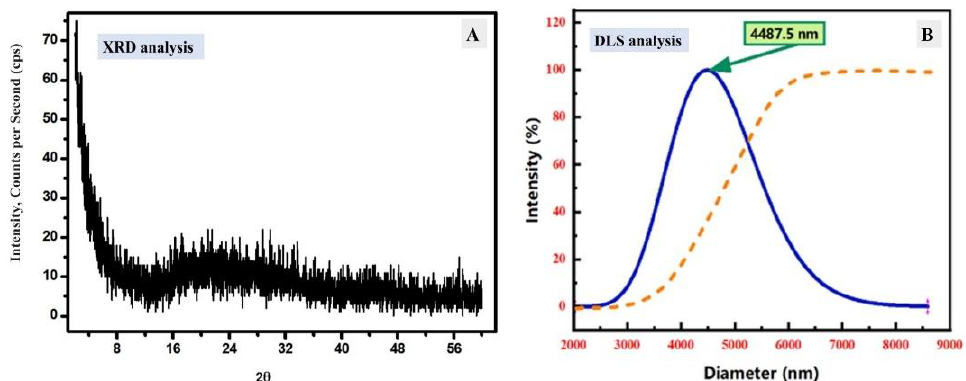
Figure 2. ( A ) XRD analysis of ZnTiO@PANi composite, ( B ) DLS analysis of ZnTiO@PANi nanocomposite.